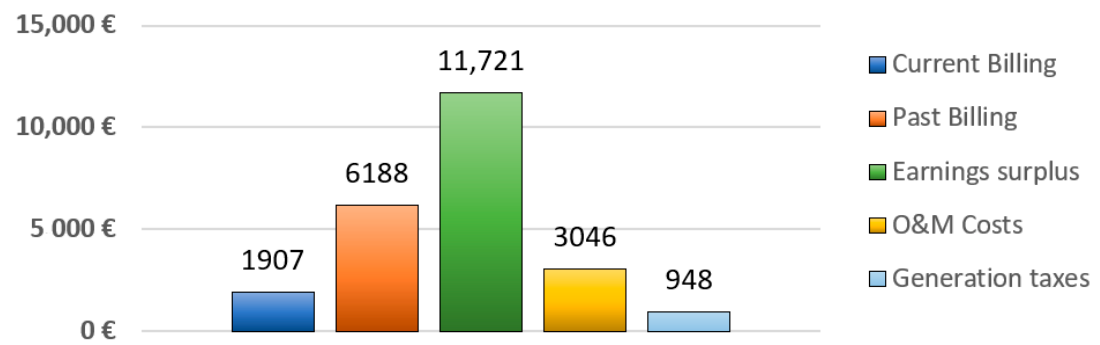
Figure 5. Breakdown of the averaged annualized costs and earnings in the second stage for the energy community. Source: self-elaboration. community. Source: Table 13. Results of the on-grid model: First-stage variables and objective function. Variables